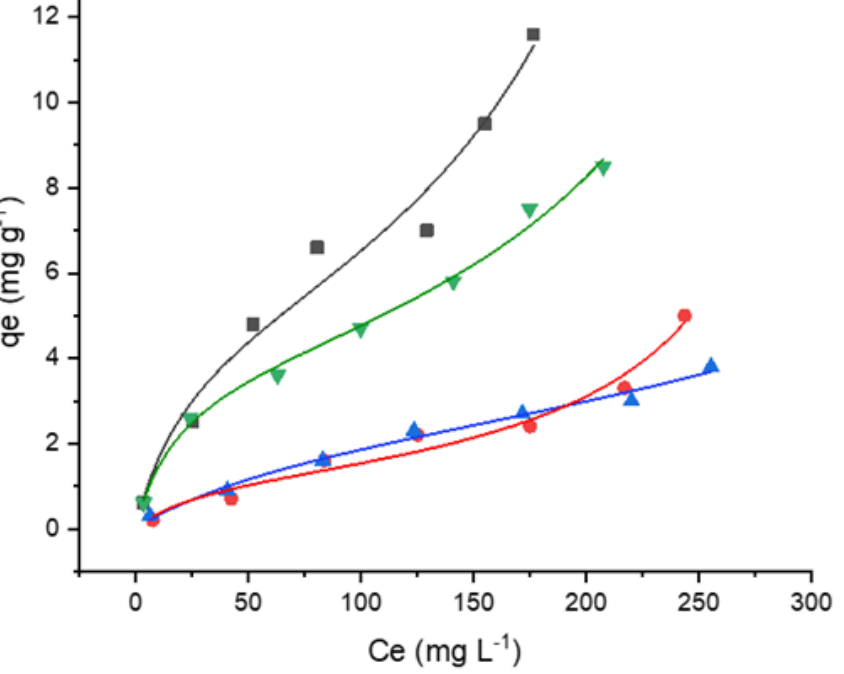
Figure 6. OFL Brunauer-Emmett-Teller (BET) profiles of SAnM ( ), SARMs ( ), FAnM ( ), and FARMp ( ) (Experimental conditions: adsorbent 100 mg, 10 mL tap water, OFL concentration 10 – 293 mg L −1 ).